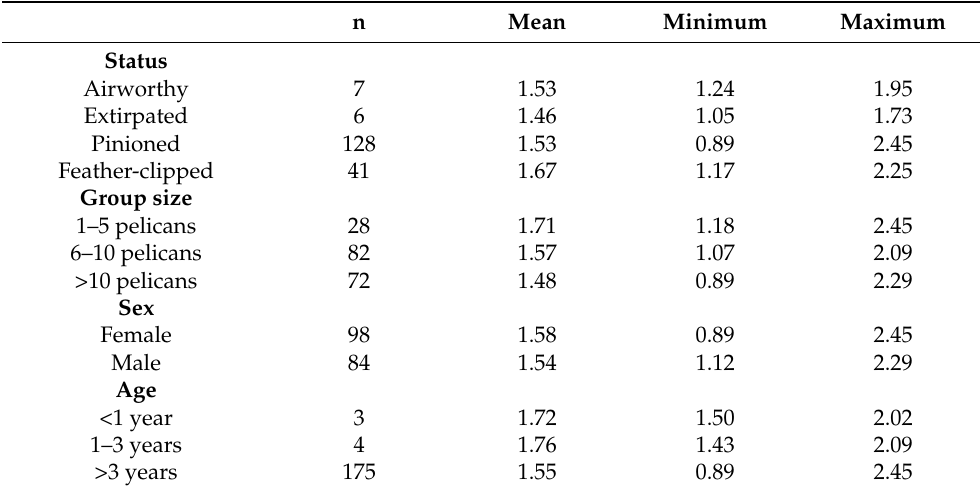
Table 3. Mean, minimum, and maximum of logarithmic CORTf values in pg/mm; n = number of pelicans in the different zoos.